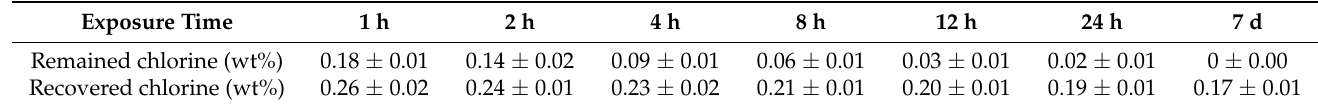
Table 3. Biocidal stability toward UV irradiation of the cyclic imide N -halamine